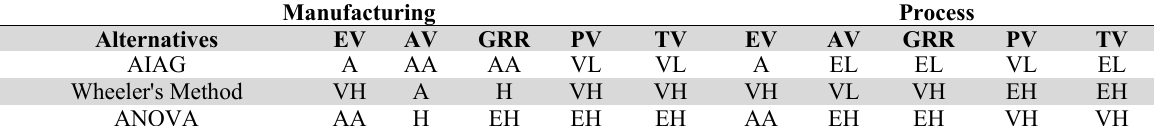
Fuzzy Denotation of Table 2 & 4